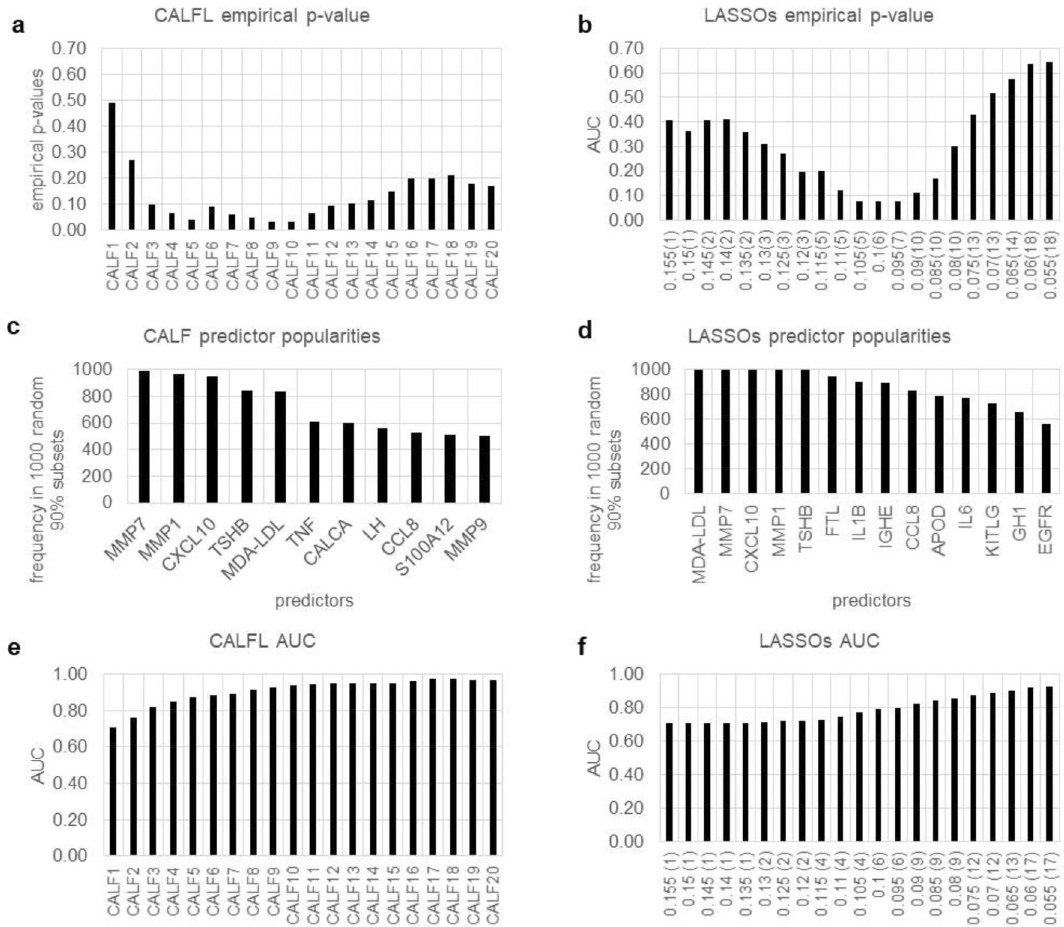
Figure 1. Comparison of CALF and LASSO logistic regression results for Example 1. ( a ) For CALF, empirical p-value is 0.040 with five predictors, that is, CALF5. ( b ) For LASSO, there are no s values for which LASSOs selects 4, 8, 9, 11, 12 14, 15, 16, 17, or 20 predictors. Otherwise, the lowest empirical p-value 0,076 occurs with s = 0.10 (six predictors). ( c ) A popularity cliff for CALF occurs at five predictors but ( d ) there is no comparable cliff for LASSO. ( e ) CALF5 AUC is 0.873, but ( f ) LASSOs does not match this until s reaches 0.075 with 12